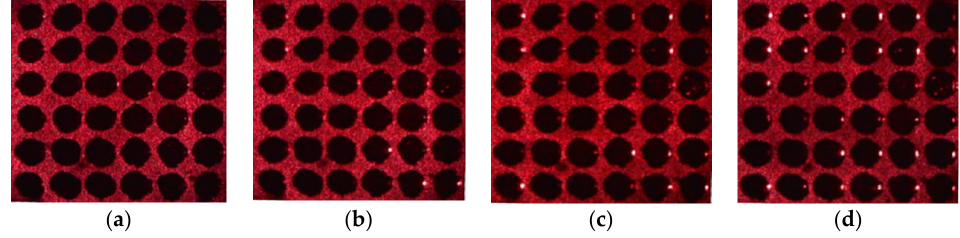
Figure 1. Microarray images obtained by digital microscope as a laser produces incident at different angles. ( a ) 0°; ( b ) 3°; ( c ) 5°; ( d ) 7°.